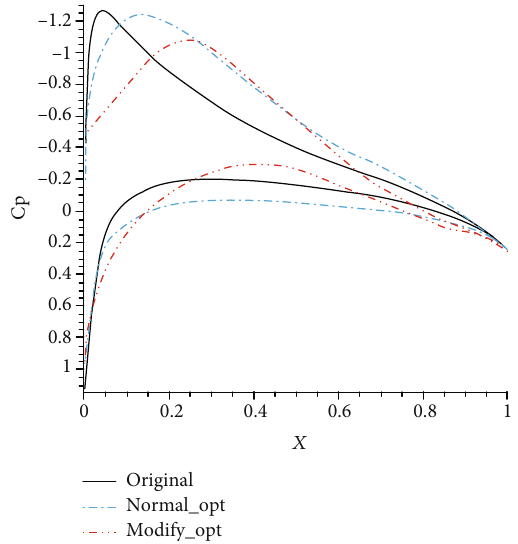
Figure 9: Pressure coe ffi cient distribution of airfoil after conventional optimization. Table 3: Comparison of optimization results. Original Parameter